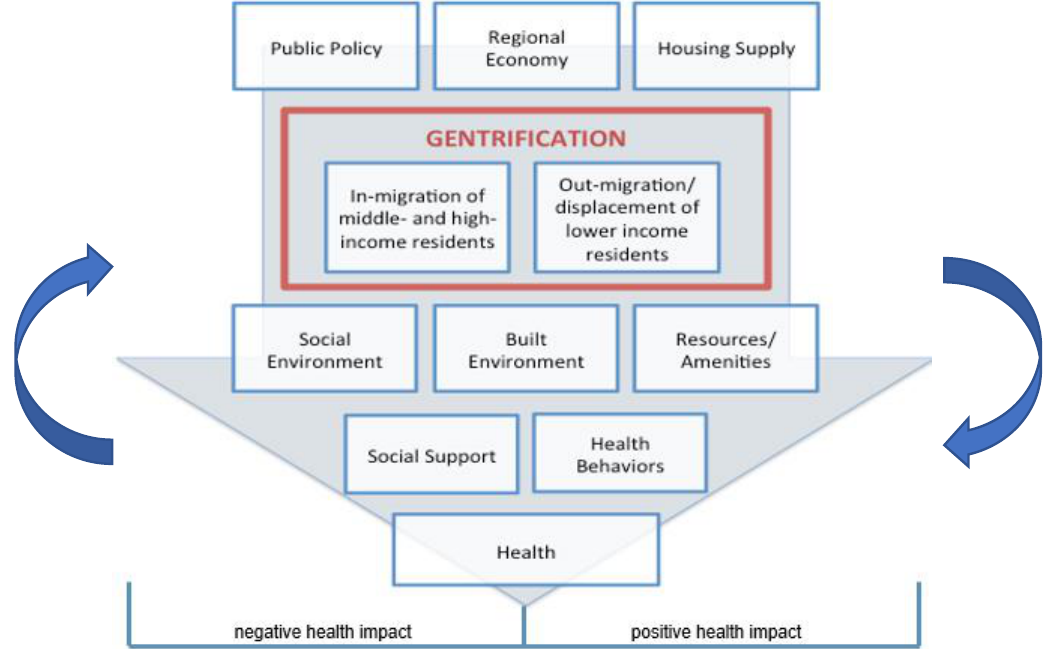
Figure 1. The conceptual framework of the potential health impacts of gentrification.